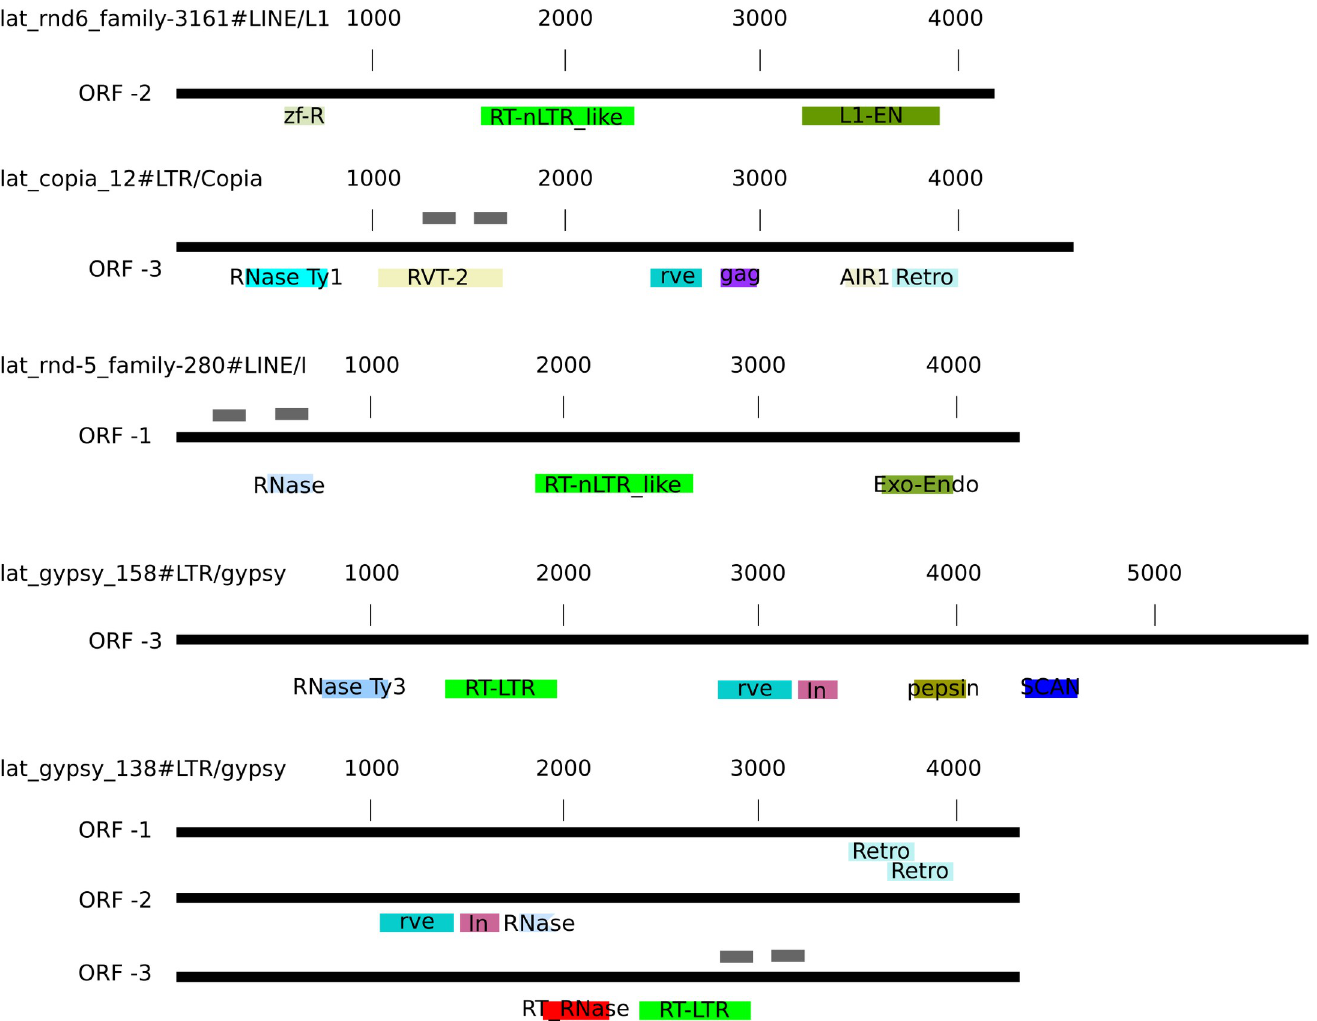
Fig 3. Schematic ORF distribution of the differentially expressed TE families. The predicted ORFs with characteristic TE domains are indicated. The numbers represent the length (in base pairs) of the TEs. The different domains are highlighted in different colors. The primers used for qRT-PCR analysis are indicated in gray, above the corresponding TE. For Olat_rnd − 5_family − 280#LINE/I, Olat_gypsy_138#LTR/gypsy, and Olat_copia_12#LTR/Copia the domain structure of the genomic locus indicated in the results part is shown; they are encoded on the reverse